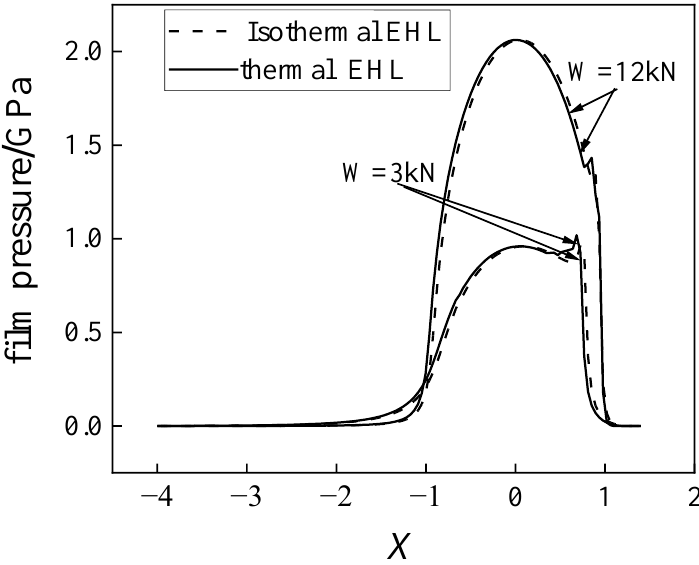
Figure 4. Effect of Radial Load on Oil Film Pressure Distribution.